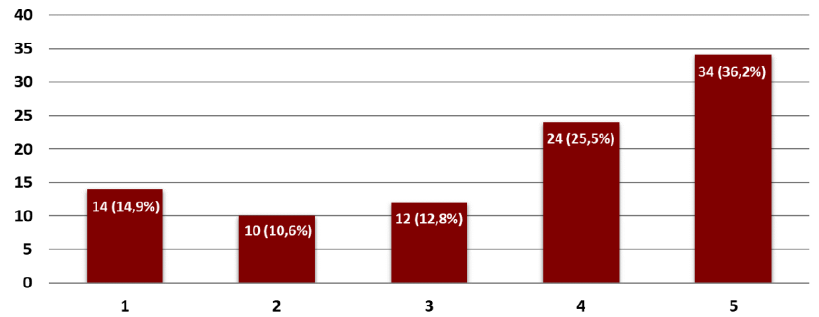
Figure 4. Level of interest for the implementation of an on board system for preventive maintenance on a rotary harrow taken out from the questionnaire.